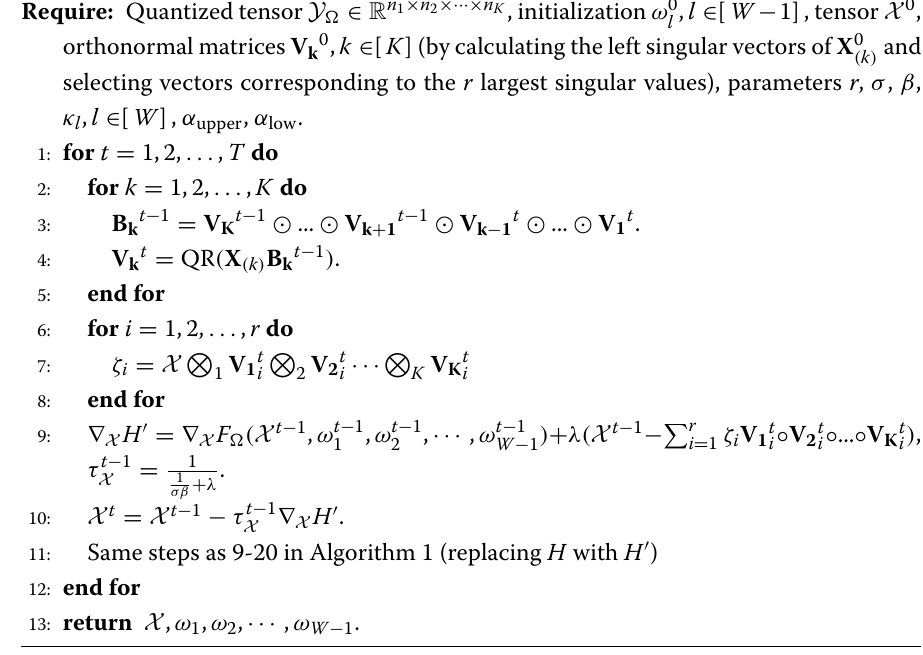
Algorithm 2 TSVD Based Alternating Projected Gradient Descent